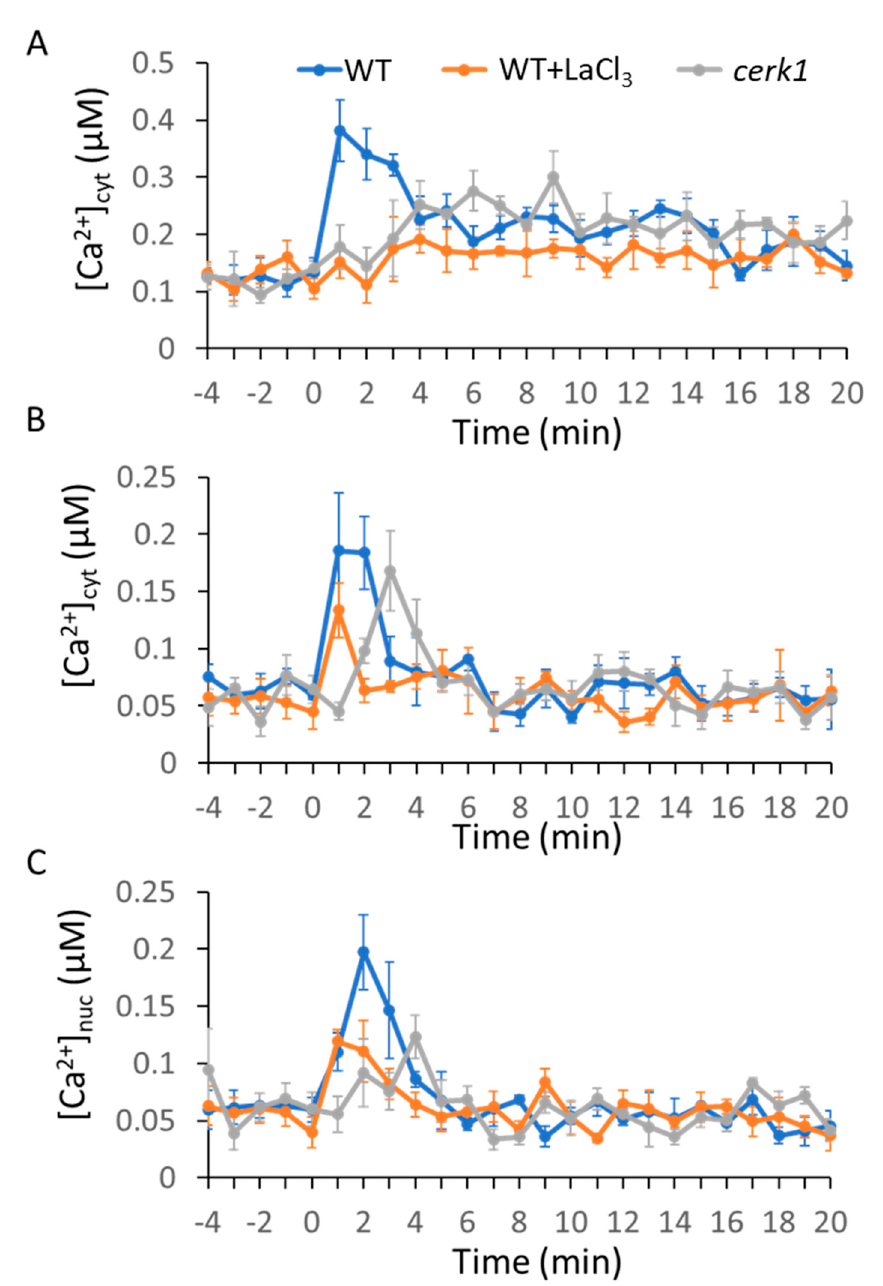
Figure 2. Chitin-induced cytoplasmic or nuclear Ca 2 + transients in aequorin-expressing Arabidopsis plants or transient AEQ-expressing mesophyll leaf protoplasts. Here, 1 µ M chitin was added at time 0 min to wild-type (WT; blue lines), WT with La Cl 3 (orange lines), or atcerk1 mutant plants (grey lines) as noted in ( A – C ). ( A ) The leaf samples. ( B ) Leaf mesophyll protoplasts transfected with AEQ. ( C ) Leaf mesophyll protoplasts transfected with AEQ-NLS. The curves shown are averages generated from four biological replicates; leaves for each replicate were taken from di ff erent plants. The bioluminescence was measured at 1 min time intervals, and SE was calculated for each mean; SE values are portrayed as error bars.